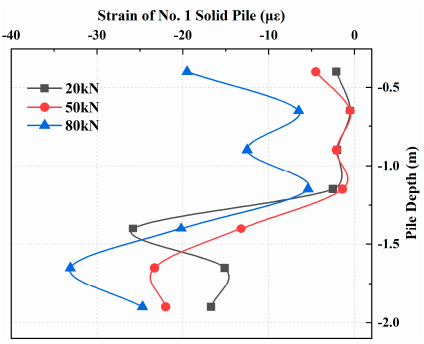
Figure 11. Pile strain of Solid Pile No. 1.